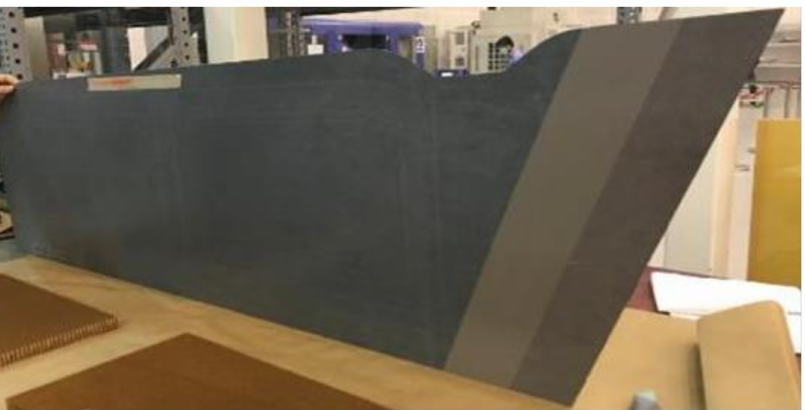
Figure 4. Demonstrator trailing edge panel of a horizontal tail, an example for the combination of conventional materials like carbon fibers with partly bio-based epoxy resin developed during the ECO-COMPASS